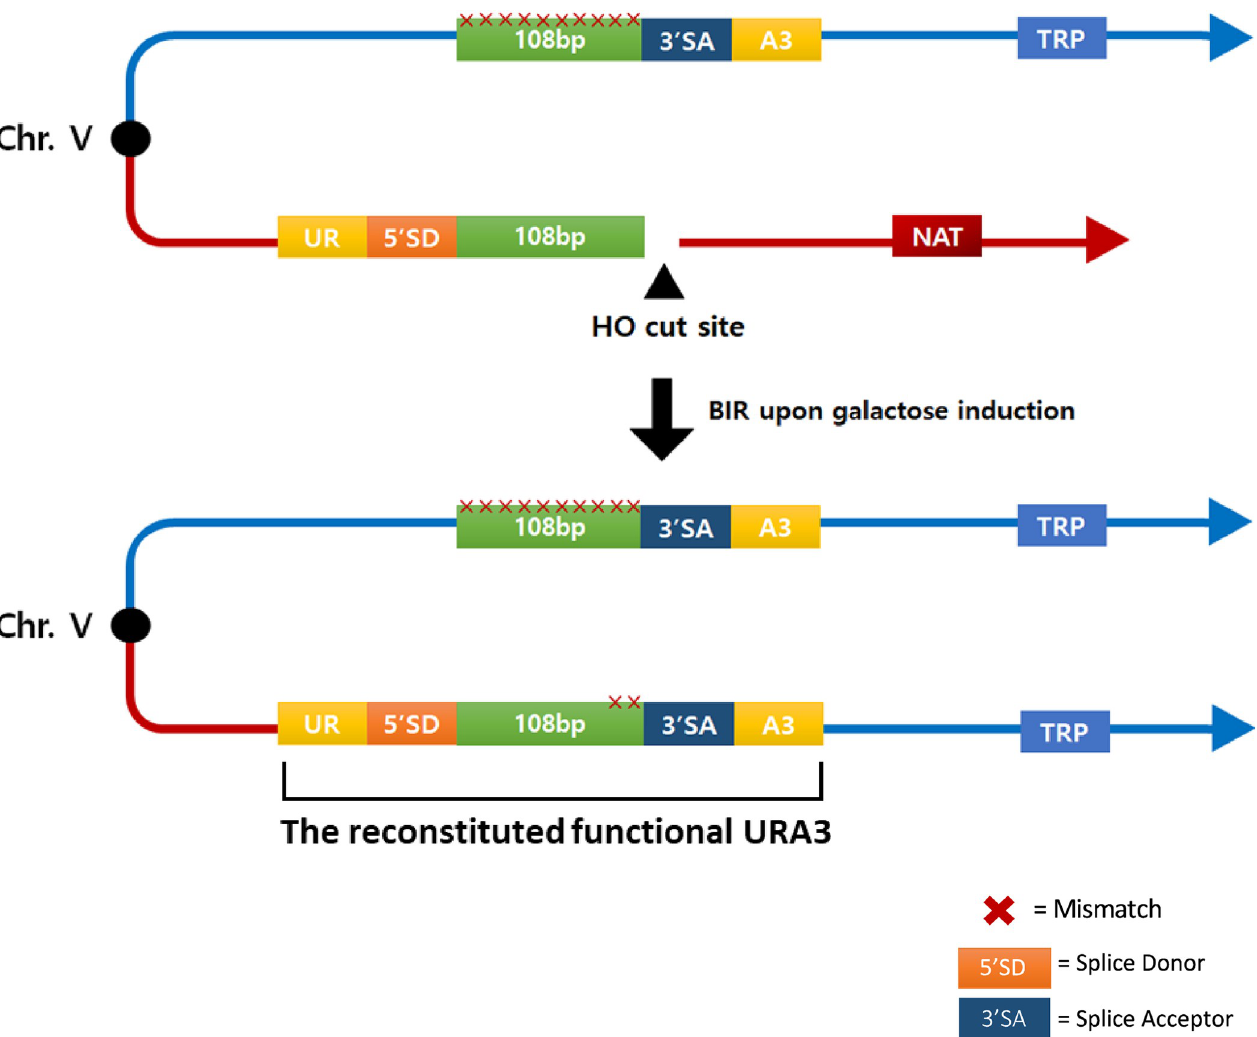
Fig 1. BIR-dependent formation of a functional Ura3 + recombinant. The recipient sequence shares the 108-bp region of homology and contain the 5’ sequences from the URA3 gene (UR), the splice donor site (5’ SD) of an artificial intron and the HO cut site. 108-bp donor sequences containing different mismatch distributions were assembled into a plasmid containing the 3’ sequences from the URA3 gene (A3), the 3’ splice-acceptor (3’ SA) of the intron and the TRP1 auxotrophic maker. A DSB was created using the galactose-inducible HO endonuclease. This break is repaired by BIR using the donor sequences that share 108-bp of homology located on the opposite arm of chromosome V. Once BIR is complete, a functional intron is formed, and yeast become Ura3 +